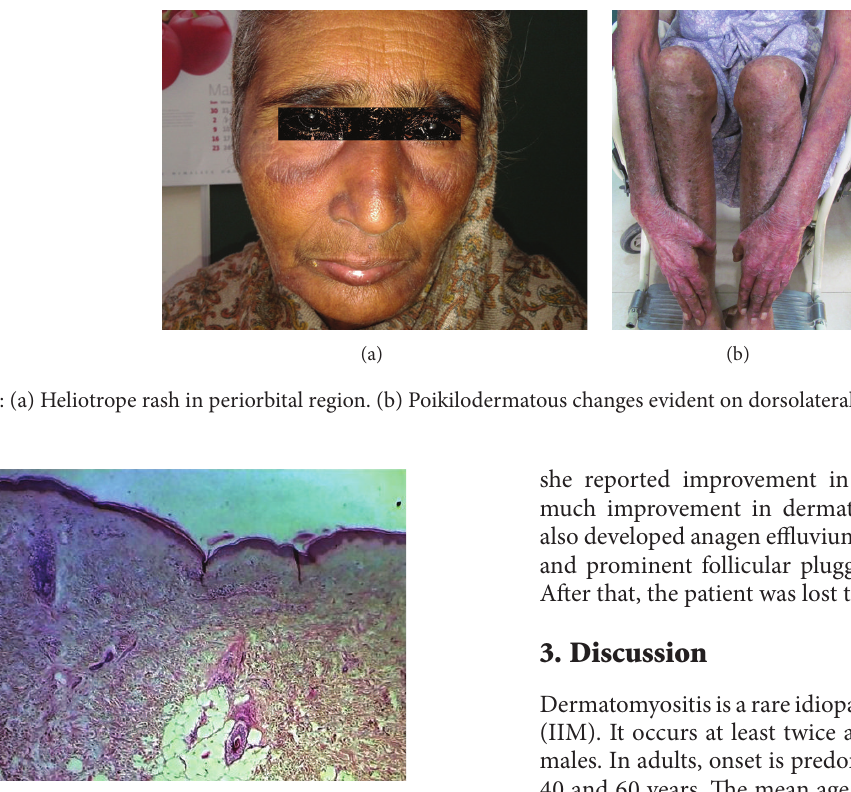
Figure 2: Histopathology of skin: focal thinning of epidermis along with hydropic degeneration of the basal keratinocytes. Deposition of eosinophilic material was seen particularly at dermoepidermal junction. There was sparse perivascular lymphomononuclear cell infiltrate in the